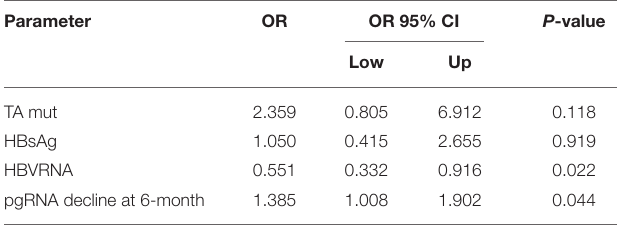
TABLE 3 | Multivariate regression analysis of factors associated with undetectable level of serum pgRNA at year 4.